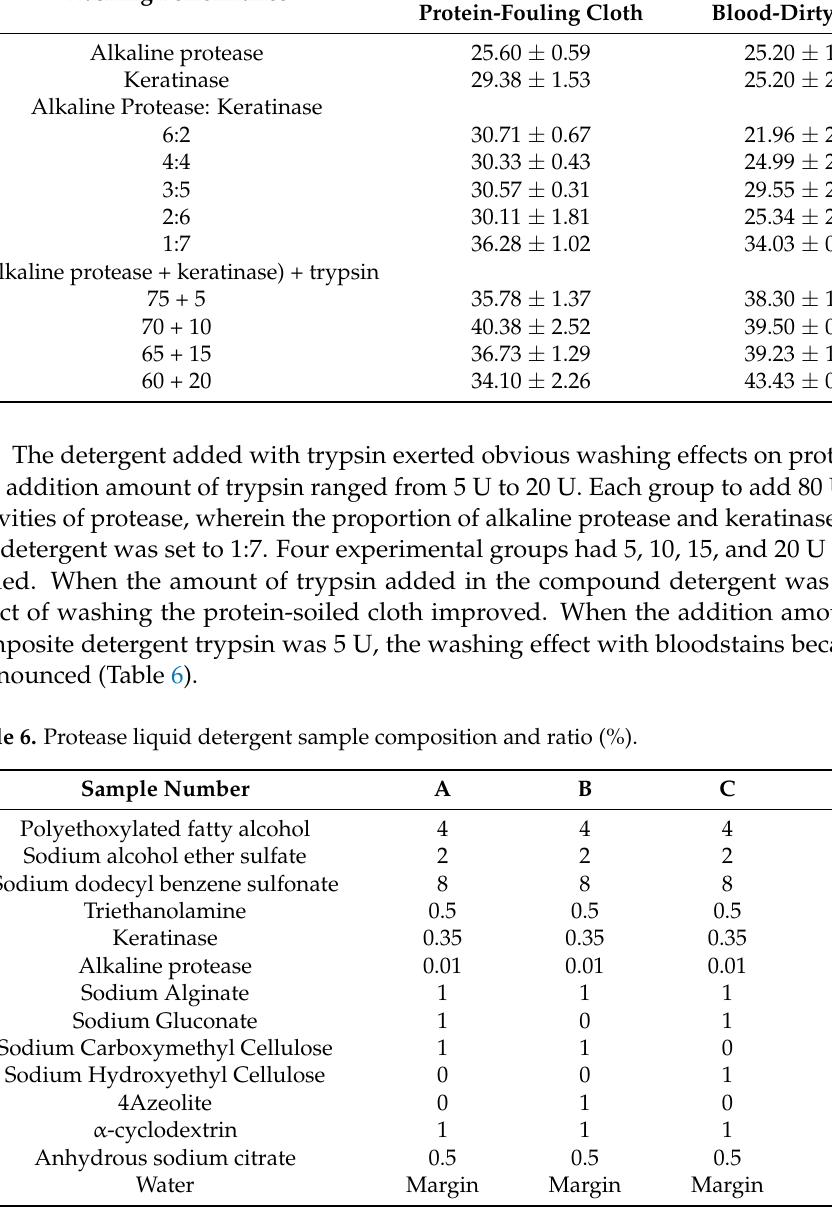
Table 5. Cleaning effect of protease compound on protein-fouling cloth and blood-dirty cloth. Washing Performance